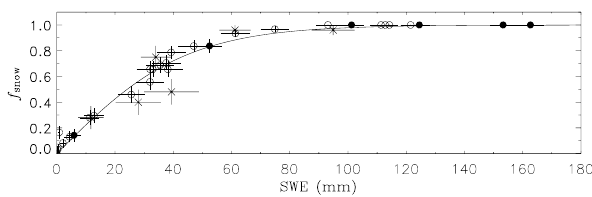
Fig. 5. Measured snow-covered fraction and average SWE, with standard error bars, for the valley site in 2003 (open circles) and 2004 (closed circles) and the plateau site in 2004 only (crosses). The fitted curve is given by Eq. (1).